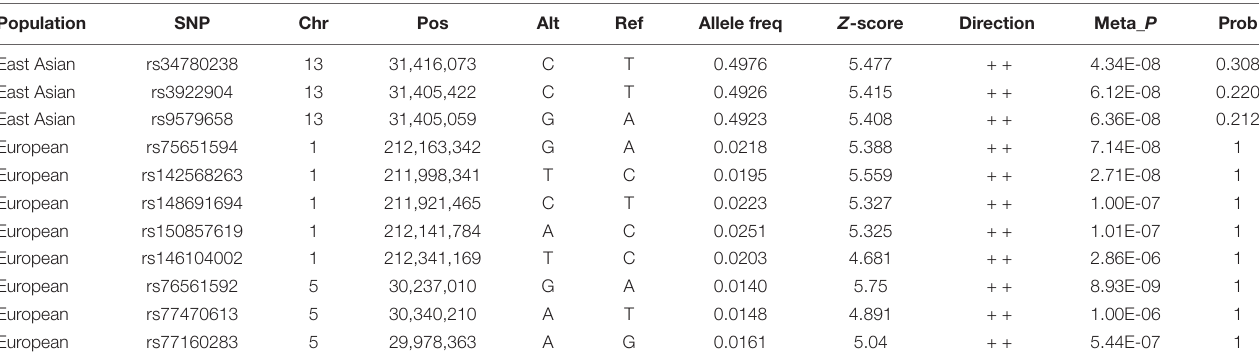
TABLE 2 | The credible sets of potential causal variants at each novel genome-wide significant